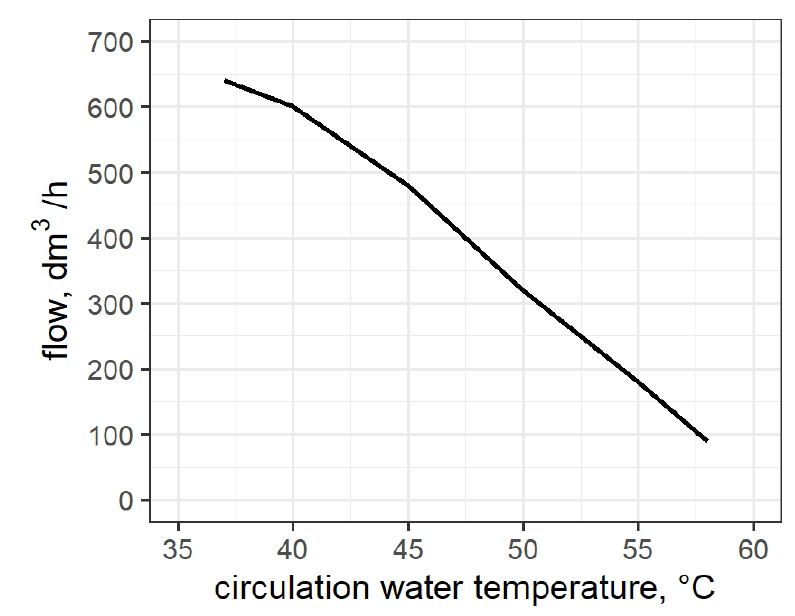
Figure 9. Changes in the minimum flow at a fluctuating circulation temperature in an MTCV thermostatic valve at a calculation pressure difference of 20 kPa